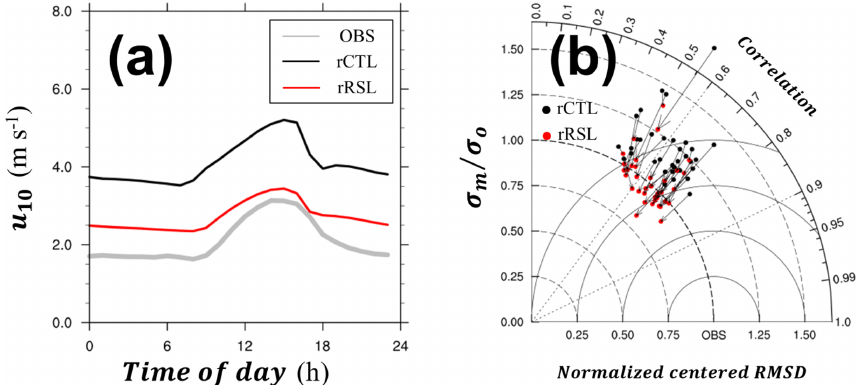
Figure 9. (a) A 1-month mean diurnal variation of 10m wind speed and (b) the Taylor diagram showing the correlation coefficient, normal- ized centered root mean square differences (RMSDs), and standard deviations of the models ( σ m ) normalized by that of observation ( σ o ) from observation (gray), rCTL experiment (black), and rRSL experiment (red). The vectors indicate the changes of the statistics from rCTL to rRSL. The arrows indicate those from rCTL to rRSL. Every vector shows the movement toward the observation, thereby suggesting the model improvement.